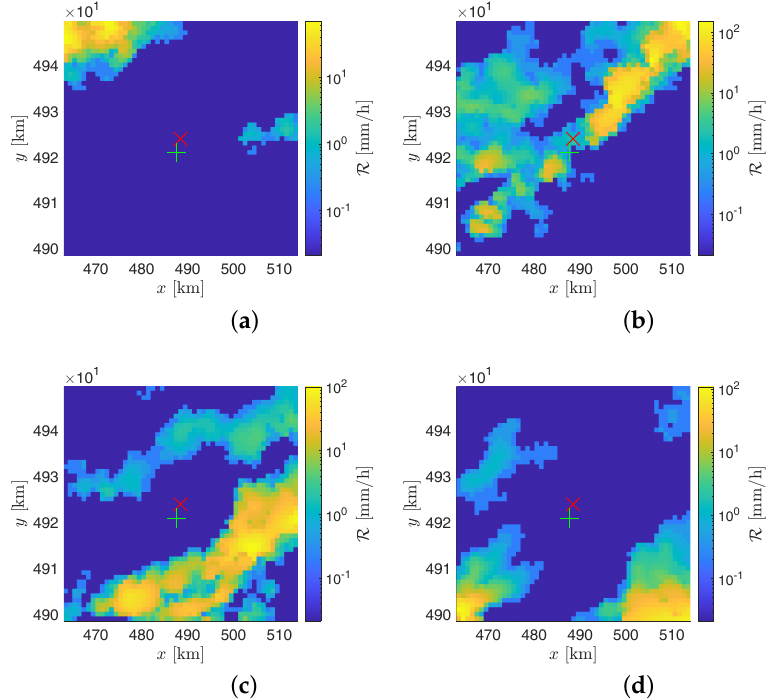
Figure 11. Precipitation maps provided by the GPM250C weather radar on the 4 July 2018 at ( a ) 1:10 UTC, ( b ) 2:00 UTC, ( c ) 2:40 UTC, and ( d ) 3:30 UTC. The red cross indicates the Monte Scarpino landfill, whereas the green plus sign indicates the RG at Monte Gazzo.